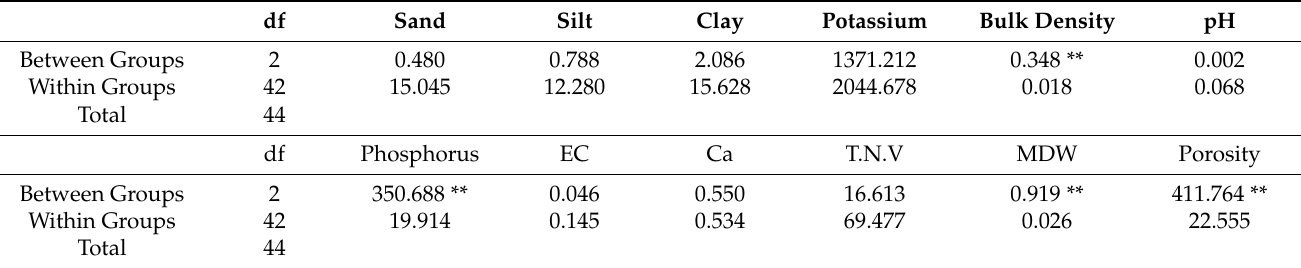
Table 2. Analysis of variances for the soil physical–chemical